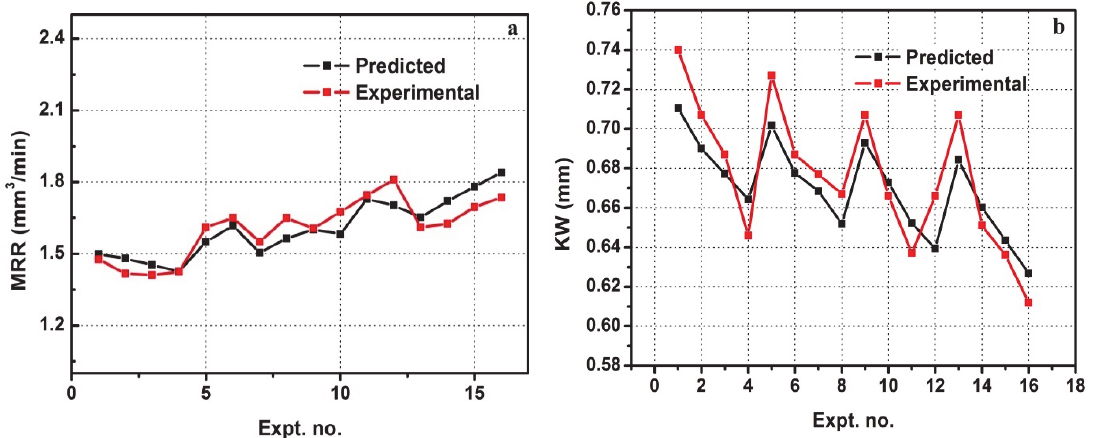
Fig. 7. Comparison between predicted and experimental model for (a) MRR (b) KW